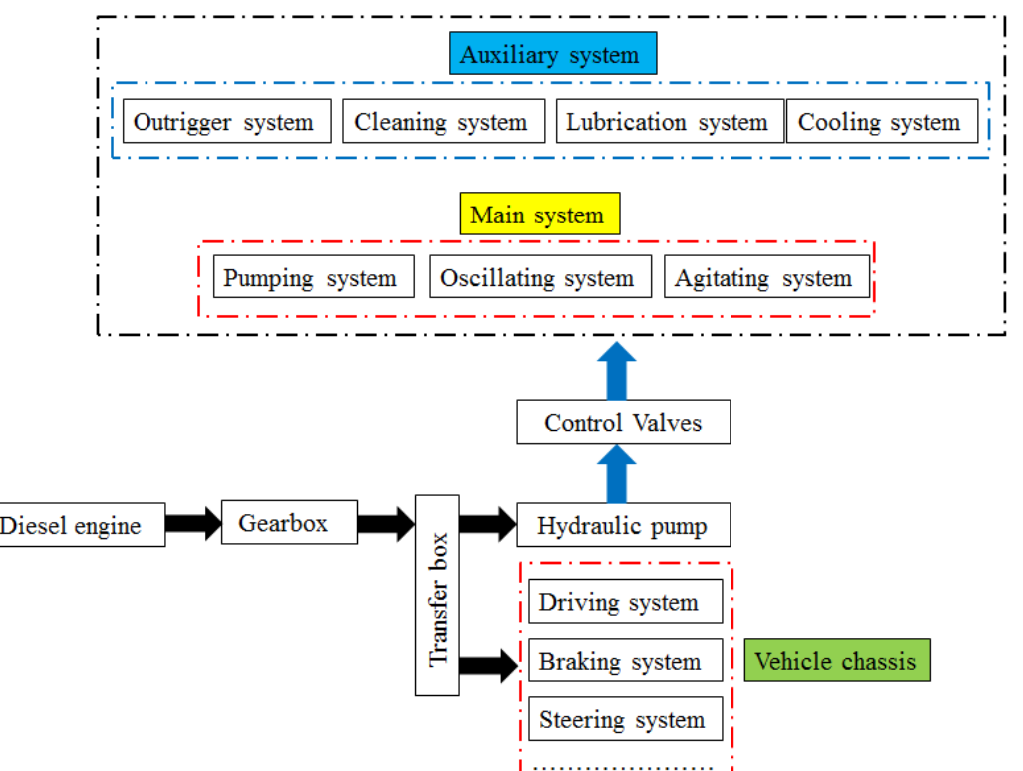
Figure 4. Structure diagram of transported concrete pump.